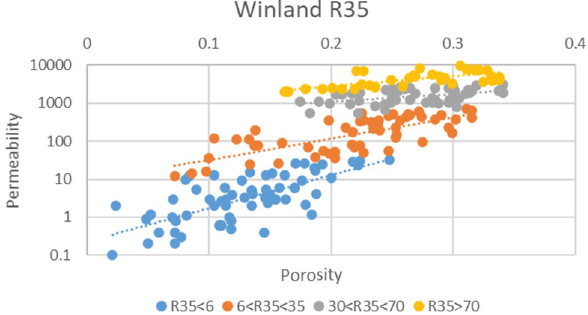
Fig. 9 Kazhdumi HFU classification results based on Winland R35 method